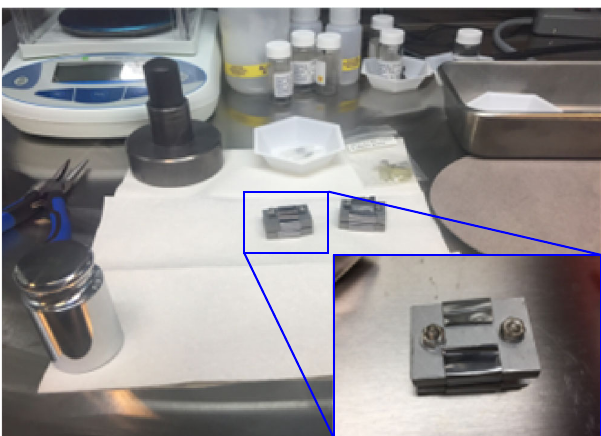
Fig. 4 Diffusion couple setup. Diffusion couple fi xed in a molybdenum-jig inside a glovebox.